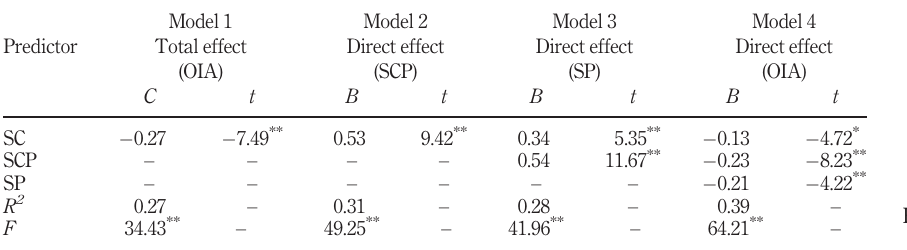
Table 3. Hypotheses